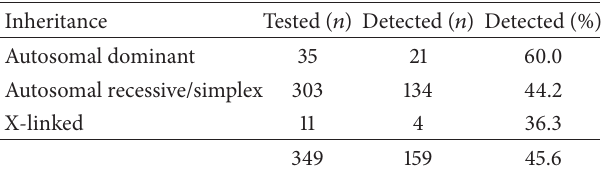
Table 1: Inherited patterns and diagnostic